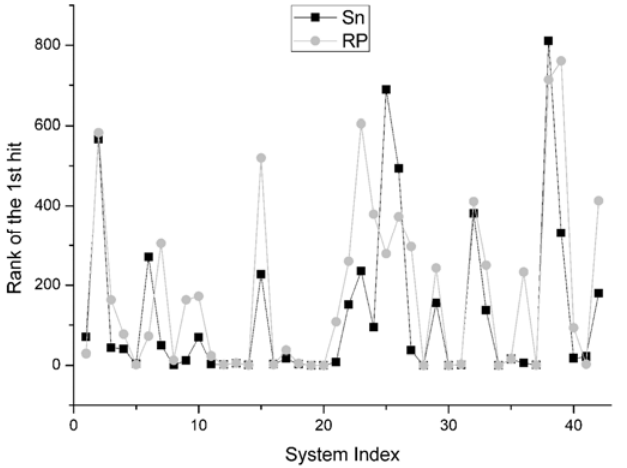
Figure 7. For the unbound dock results, the comparison of the rank of the first hit structure of the Sn and RP score function.